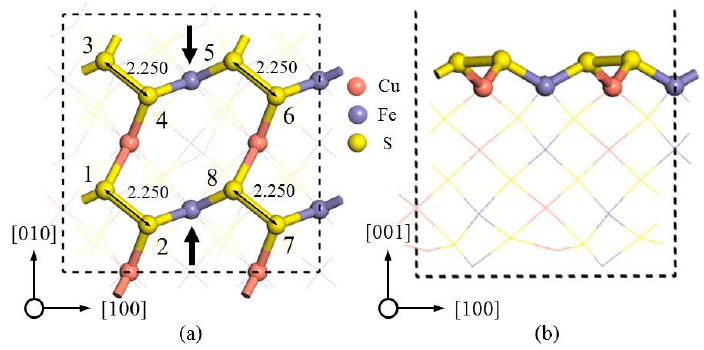
Figure 6. The adsorption sites of SO 42 − on the chalcopyrite (001)-S surface: ( a ) top view; ( b ) side view. Distances are in angstroms.